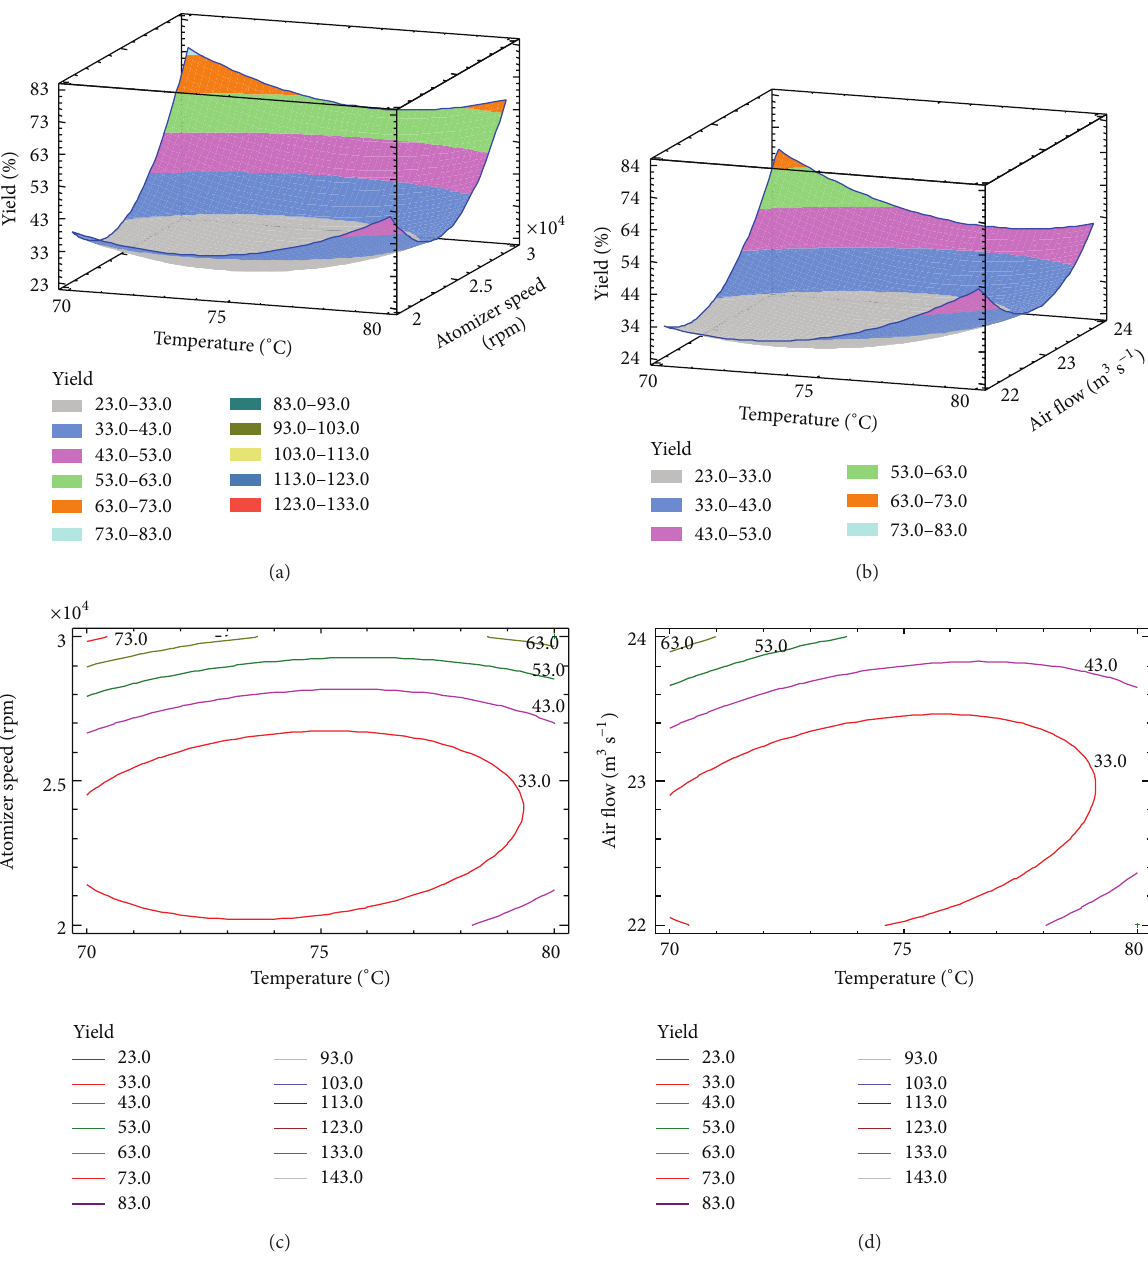
Figure 1: Surface plot showing (a) the effect of temperature and atomizer speed at air flow 0.215 m 3 s −1 and (b) the effect of temperature and air flow at an atomizer speed of 25000 rpm on the powder